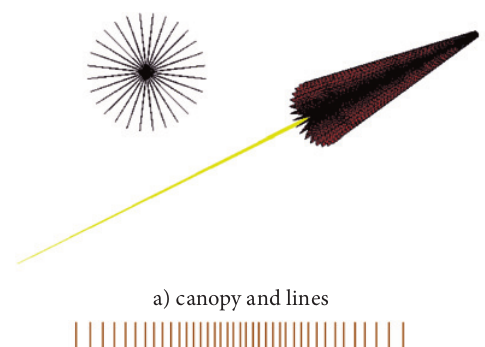
Fig. 2. Boundary conditions